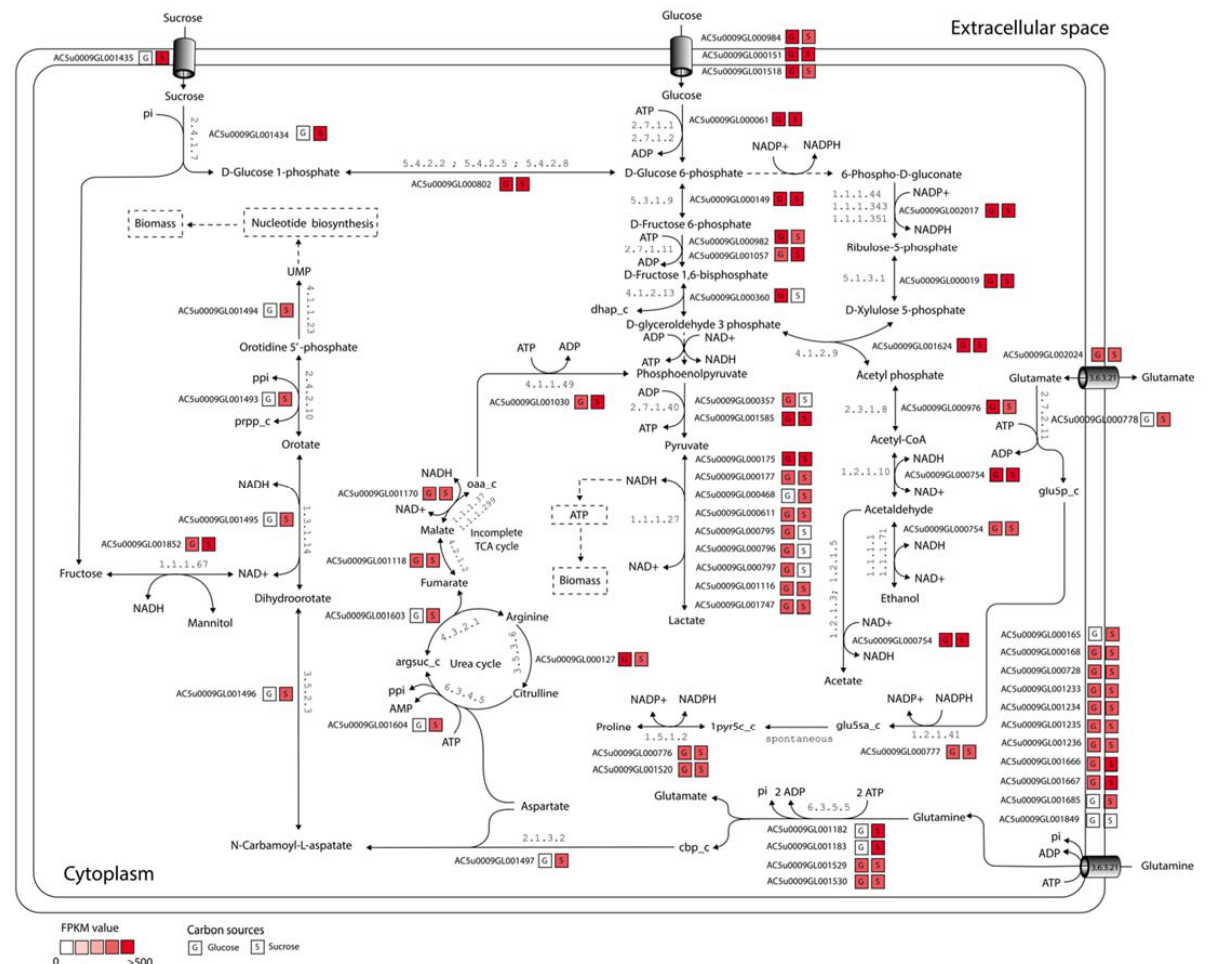
Figure 6. Potential metabolic routes for enhancing growth of L. reuteri KUB-AC5 by integrative transcriptome analysis. Abbreviated metabolite names are as follows: prpp_c, 5-phospho-alpha-ribose 1-diphosphate; argsuc_c, N(omega)-(L-Arginino)succinate; oaa_c, oxaloacetate; orn_L_c, ornithine; glu5sa_c, glutamate 5-semialdehyde; dhap_c, dihydroxyacetone phosphate; cbp_c, carbamoyl phos- phate; glu5p_c, glutamate 5-phosphate; 1pyr5c_c, 1-pyrroline-5-carboxylate. Dashed lines represent multistep